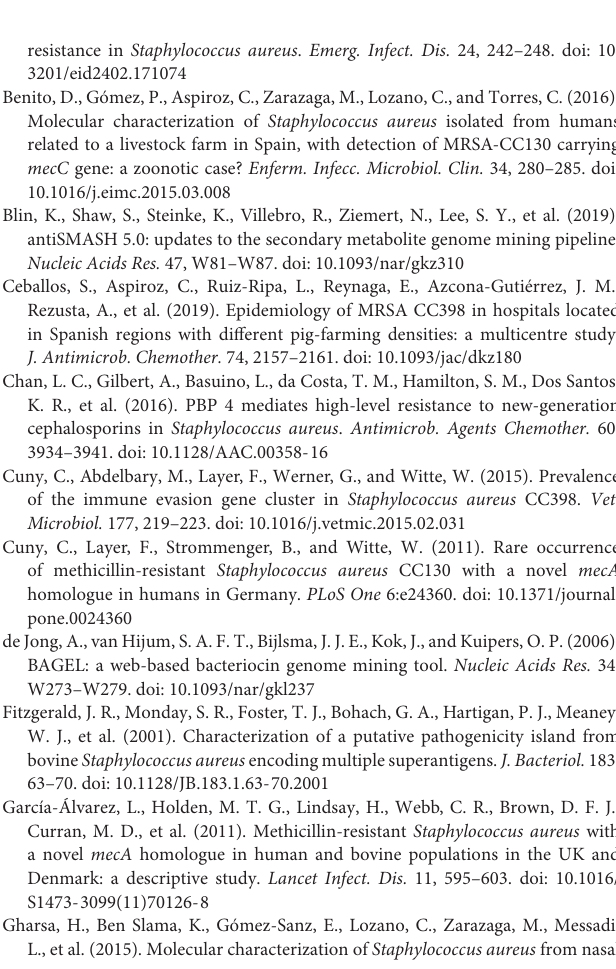
Supplementary Figure 1 | Circular comparison of MSSA in Green-blue rings and MRSA in warm colors using LGA251 as reference.% GC content and GC Skew are represented in innermost circles (colors indicated in the coded legend). Supplementary Figure 2 | (A) Amino acid comparative of scn -like found in 4 MSSA isolates of this study. (B) Amino acid comparative between one scn -like found in this study, one scn -equine (WP_106096712 as reference) and one scn -human (WP_000702262 as reference). Supplementary Table 1 | Results of whole genome sequence and accession number of the strains included in this study. Supplementary Table 2 | Result of unique genes in MRSA and in MSSA strains analyzed by Roary